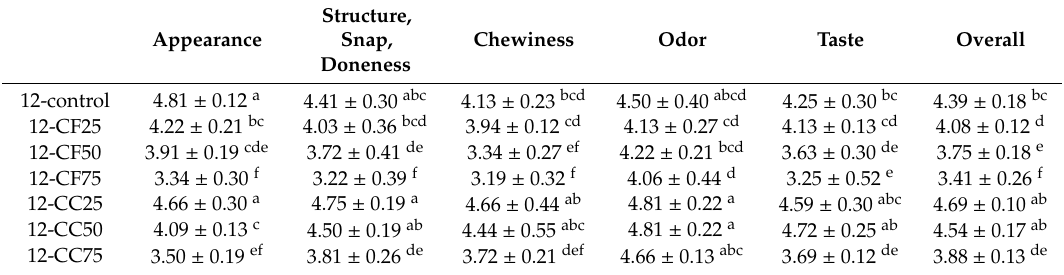
Table 3. Sensory evaluation of cookies with 25%, 50% and 75% of fine and coarse APF after 12 months of